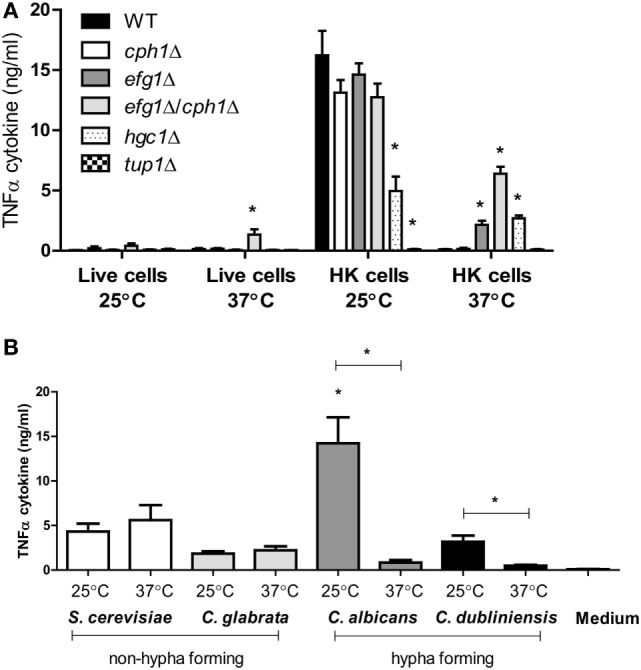
TNFα production by human peripheral blood mononuclear cells stimulated with morphological mutants of Candida albicans mutants or other yeast species. (A)
C. albicans NGY152 (WT), JKC19 (cph1Δ), HLC52 (efg1Δ), HLC54 (cph1Δ/efg1Δ), WYZ12.2 (hgc1Δ), and Bca2-10 (tup1Δ). Results are means ± SEM (n = 6; *p < 0.05). (B) TNFα stimulation by non-hypha-forming species Saccharomyces cerevisiae (S288C) and Candida glabrata (ATCC 2001) compared to hypha-forming species C. albicans (NGY152) and Candida dubliniensis (CD36) (*p < 0.05). Error bars = SEM (n = 9).